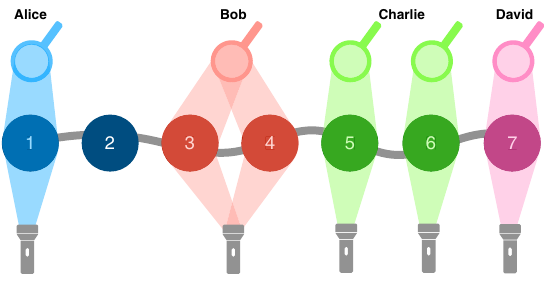
FIG. 14. Spatial measurements. Alice, Bob, Charlie, and David perform measurements on a seven-partite quantum state ρ . Both Bob and Charlie have access to two parts of said state, respectively, but while Bob can perform correlated mea- surements on said systems, Charlie can only access them inde- pendently. The probabilities corresponding to the respective outcomes are computed via the Born rule [see Eq.